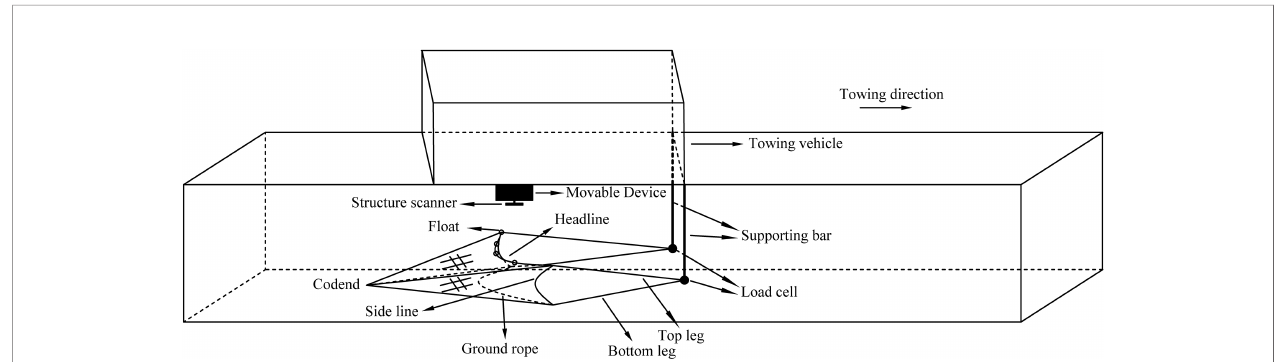
FIGURE 5 | Setup of the physical model test.